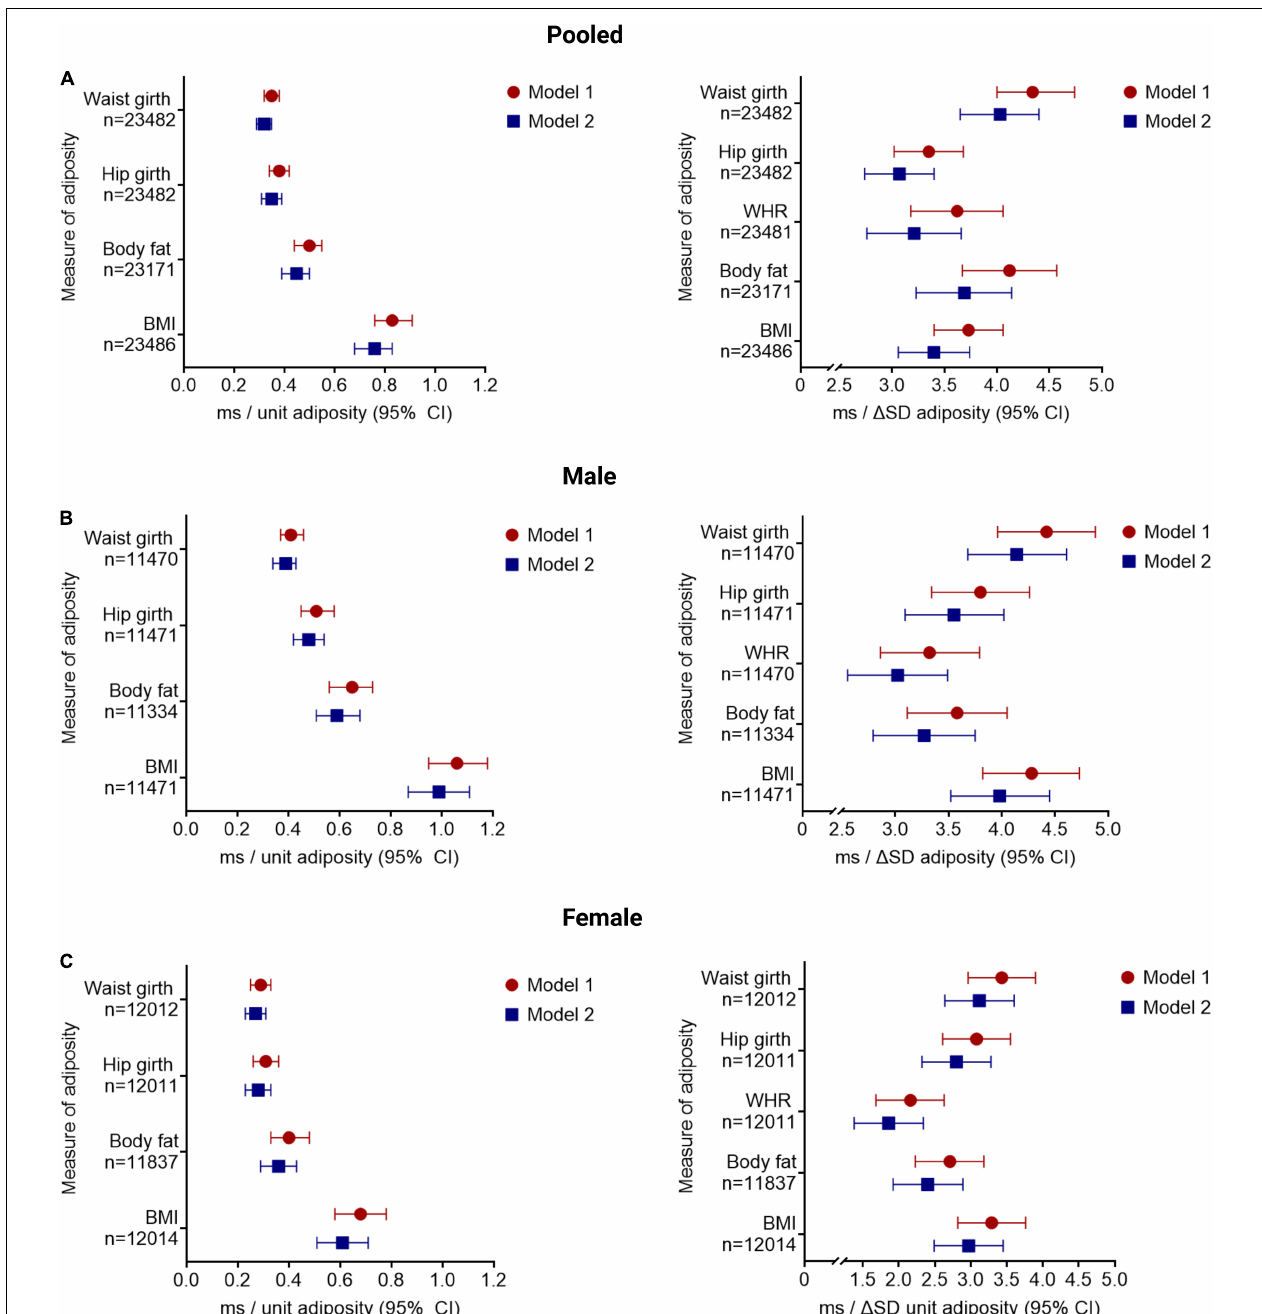
FIGURE 1 | Increasing adiposity is associated with increased QTc interval, after adjusting for sociodemographic, co-morbidity, and lifestyle factors. The change in QTc per unit and per standard deviation (SD) increment of in adiposity [quantified by BMI, body mass index (kg/m 2 ); BF, body fat (%); WHR, waist:hip ratio (unit); HG, hip girth (cm); and WG, waist girth (cm)] are shown for the pooled cohort (A) and stratified by sex (B,C) . Model 1 adjusted for sociodemographic factors; model 2 adjusted for lifestyle and comorbidities. All results presented reached significance p < 0.001. Results for QTc change per unit increment in WHR is provided in the main